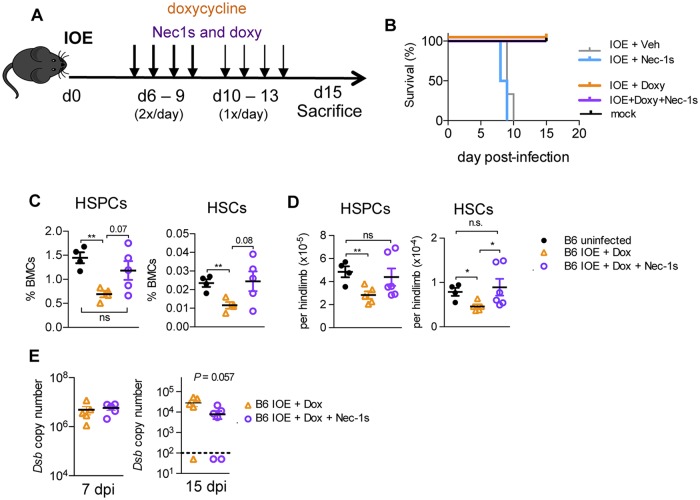
Targeting RIPK1 improves hematologic recovery in IOE infection survivors.(A) Mice were mock- or IOE-infected mice and treated with vehicle (Veh), Nec-1s, doxycycline (Doxy)-, or Doxy+ Nec-1s, as shown. (B) Survival of mock- (black line) or IOE-infected mice treated with vehicle (gray line), Nec1s (blue line), Doxy (orange line), or Doxy + Nec1s (purple line). (C) Surviving mice were evaluated at 15 d.p.i. for frequencies of BM HSPCs and HSCs, n = 5 mice/group, 4 mice/mock group. (D) Numbers of HSPCs and HSCs in mock and Veh-, Doxy-, and Doxy + Nec-1s-treated mice 15 d.p.i (E) Bacterial burden in the spleens of Doxy-, and Doxy + Nec-1s-treated mice 7 and 15 d.p.i., represented as Dsb copy/50ng total DNA. n = 3–5 mice/group. Dashed line represents the limit of detection. * P < 0.05, ** P < 0.001.